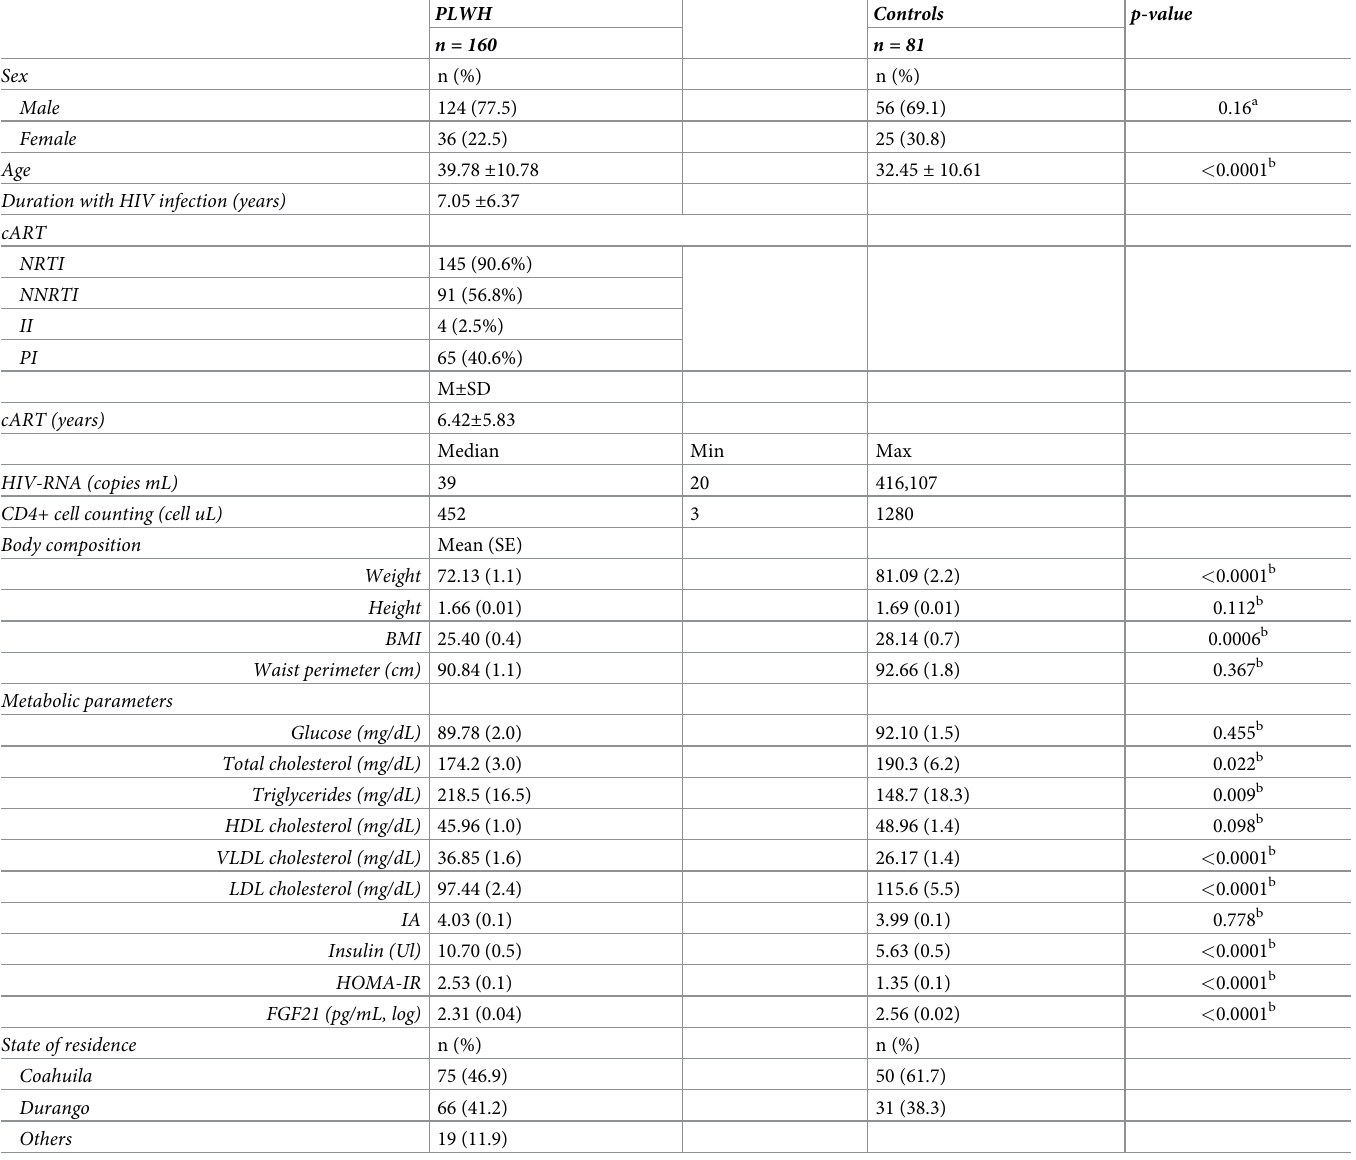
Table 1. Demographic and clinical characteristics of the study